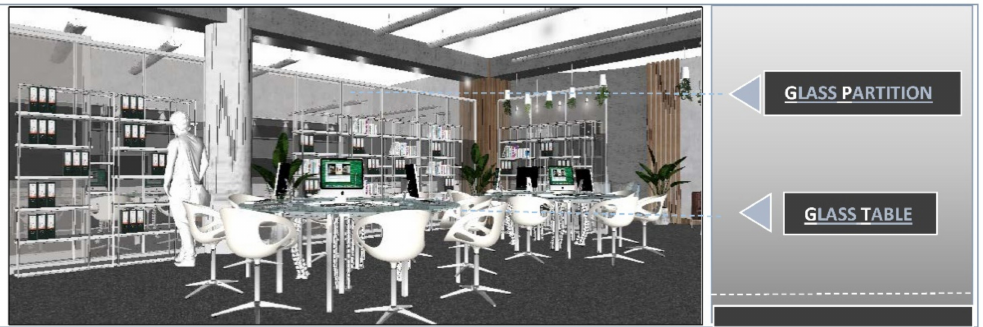
Figure 16. The interior design of the reading space contains modern glass tables and storage units for books and internal borrowing.